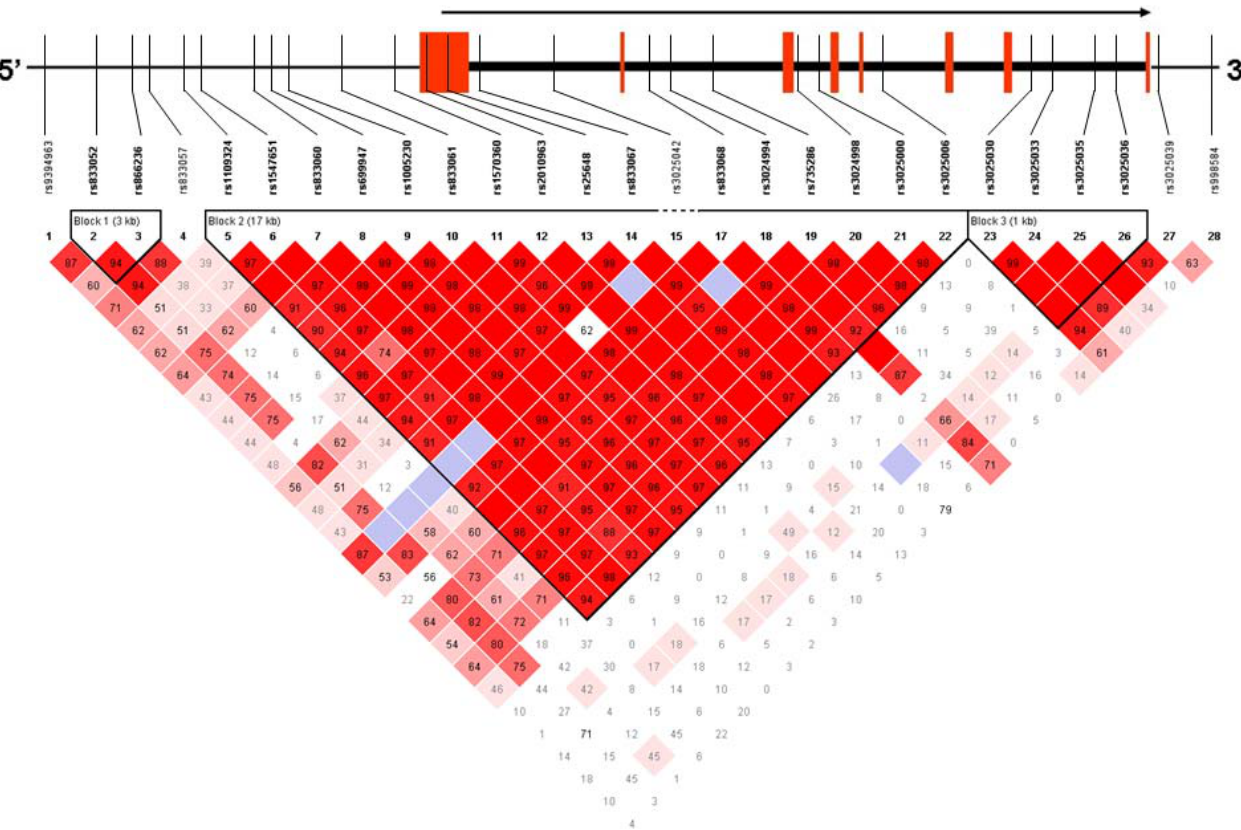
Figure 1. Gene Map and LD Plot of VEGF Gene Color scheme is based on D 9 and logarithm of the odds of linkage (LOD) score values: white D 9 , 1 and LOD , 2, blue D 9 ¼ 1 and LOD , 2, shades of pink/red: D 9 , 1 and LOD (cid:3) 2, and bright red D 9 ¼ 1 and LOD (cid:3) 2. Numbers in squares are D 9 values (values of 1.0 are not shown). Block definition is based on the Gabriel et al. method [34]. Two (rs3024989 and rs367173) of the 29 SNPs determined are not shown because of low variation in this population. Red rectangles in the gene map represent